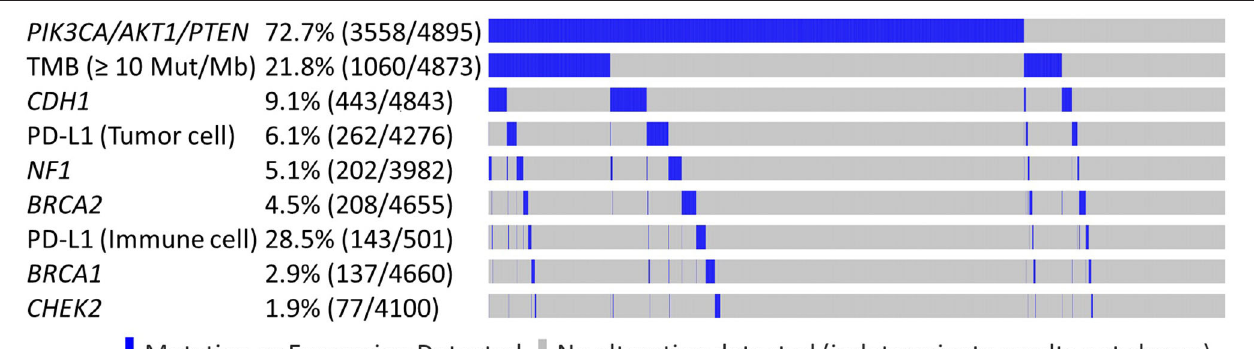
FIGURE 2 | Genomic features observed in PIK3CA/AKT1/PTEN altered and non-altered tumors. Oncoprint plot illustrates co-occurrence of possible driver events and events associated with mutual